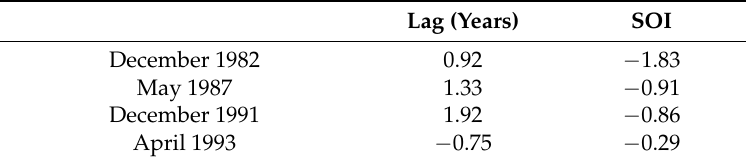
Table 2. Four new events are considered when comparing the SOI/RH (Rainfall